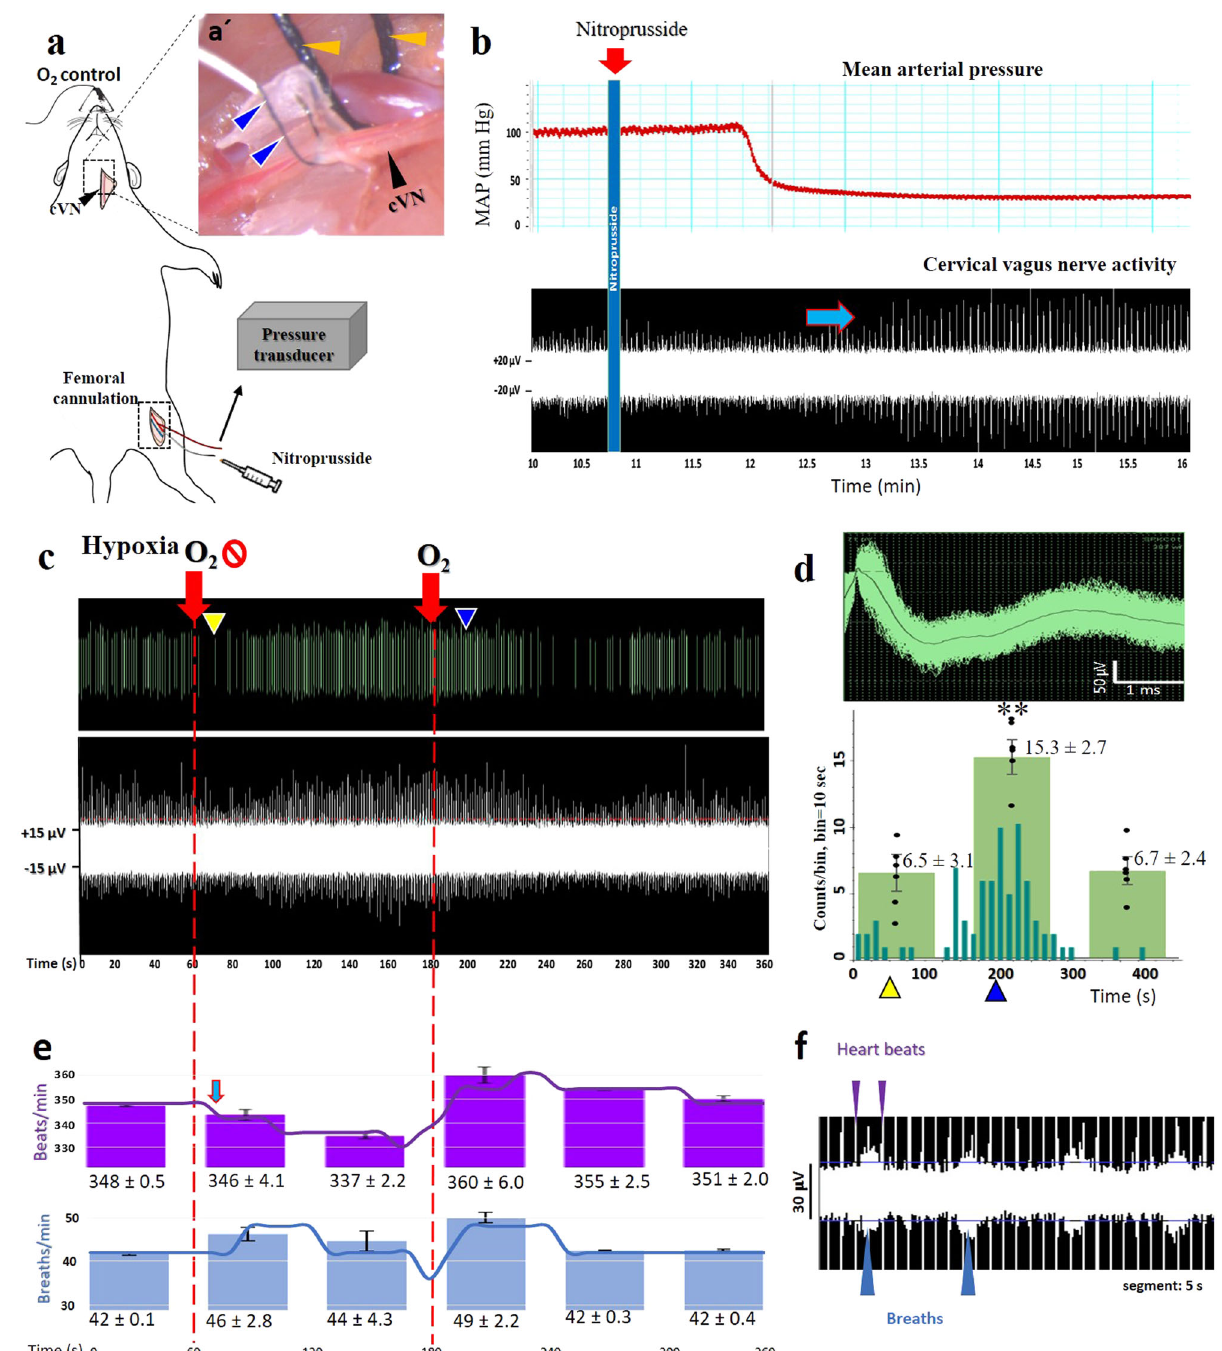
Fig. 2 Vagal neuronal activity evoked by hypotension and hypoxia recorded by sutrode. a Schematic of sutrode placement on the rat cVN, with a femoral arterial blood pressure sensor. a ’ The cVN (black arrow) was interfaced with a sutrode (blue arrows). A conventional 4-0 nylon suture was used to isolate the carotid artery (yellow arrows). b Nitroprusside (red arrow) induced hypotension, that correlated with an increase in cVN fi ring rate (blue arrow). c Oxygen restriction induced an initial decrease (yellow arrowheads) and a subsequent 10-fold increase (blue arrowheads) in vagal activity. d Representative rate histogram of an isolated waveform (dark green bars), and graph (overlapped) of average total neuronal activity n = 6 experiments from n = 3 rats (averages ± SD), whiskers represent con fi dence intervals ** p < 0.01. Oxygen restriction and restoration are pointed as red arrows in c . e The Oxygen reduction corresponded to a slight decrease in heart rate (blue arrow), and a subsequent increase in respiration rate calculated from f un fi ltered raw data fi les. Values are from a representative rat, and overlapped bars are presented as the average ± SD of three